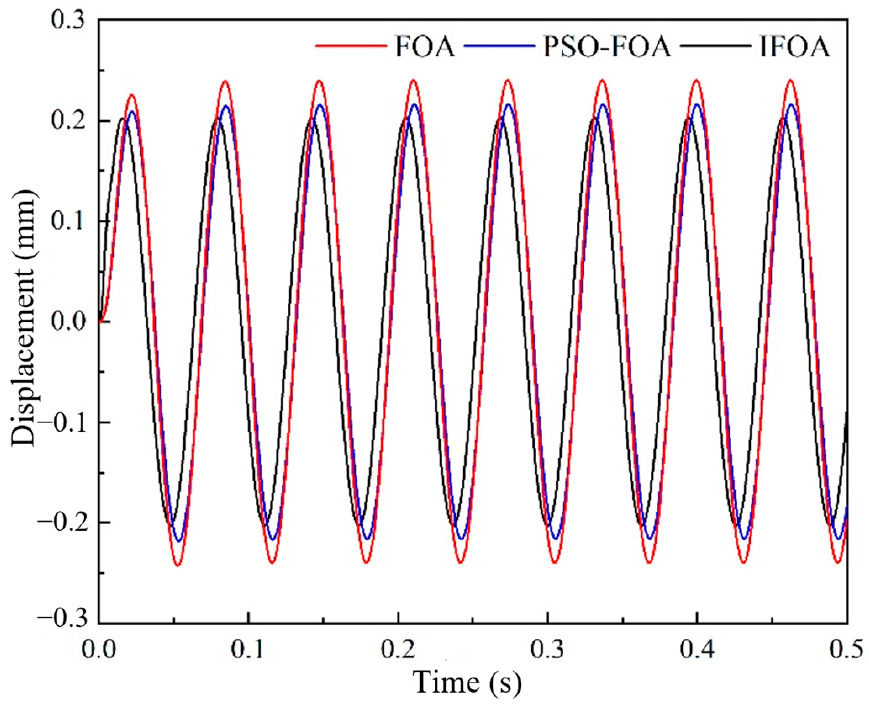
Figure 15. Vibration displacement of vehicle body (n = 2980 r/min).